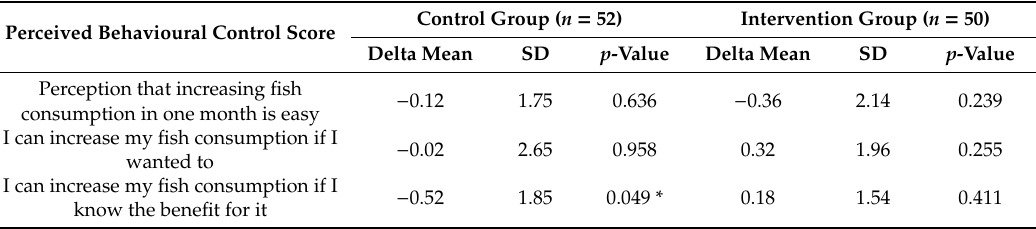
Table 5. Change in children’s perceived behavioral control towards fish consumption after 3 months of intervention.